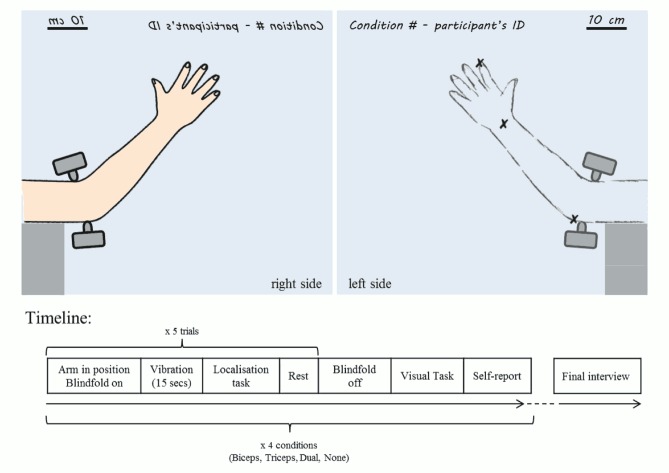
Experiment 2: setup and timeline.